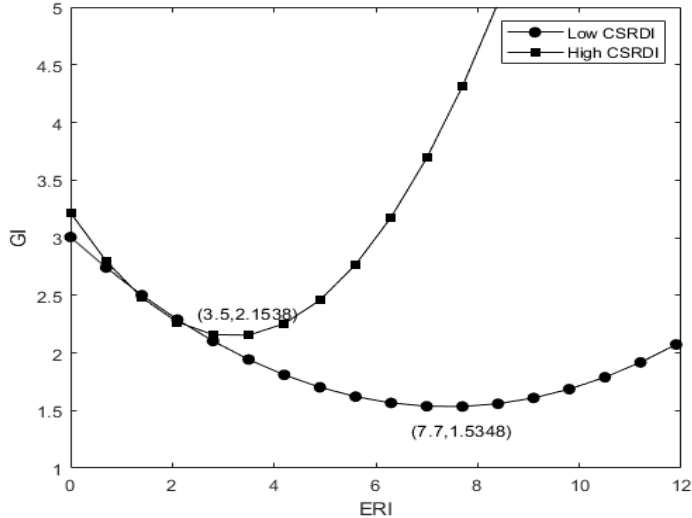
Figure 4. Comparison of the U-shaped relationship between environmental regulation and green innovation in state-owned and non-state-owned enterprises.